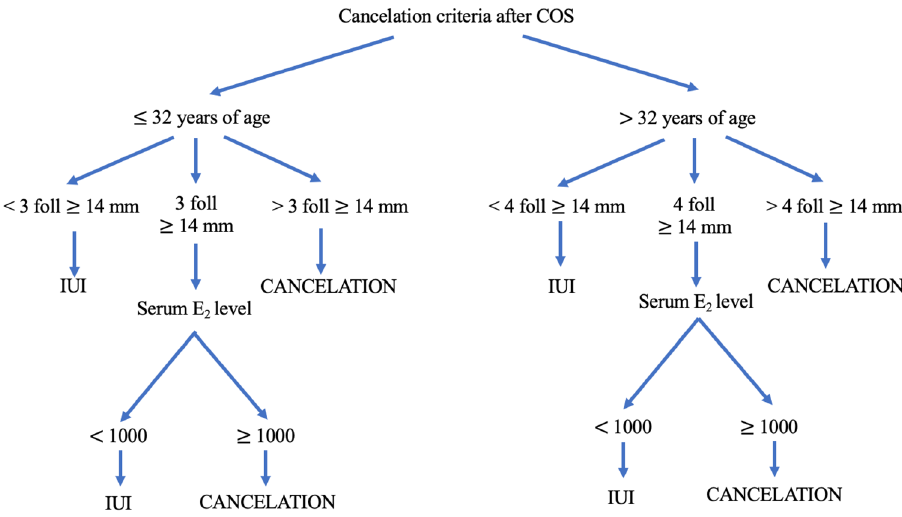
Figure 4. New algorithm for cycle cancelation of COS-IUI